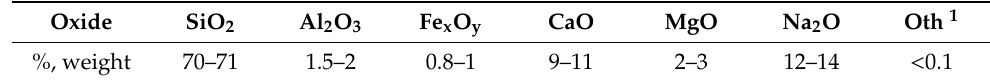
Table 2. Glass powder oxide chemical composition.